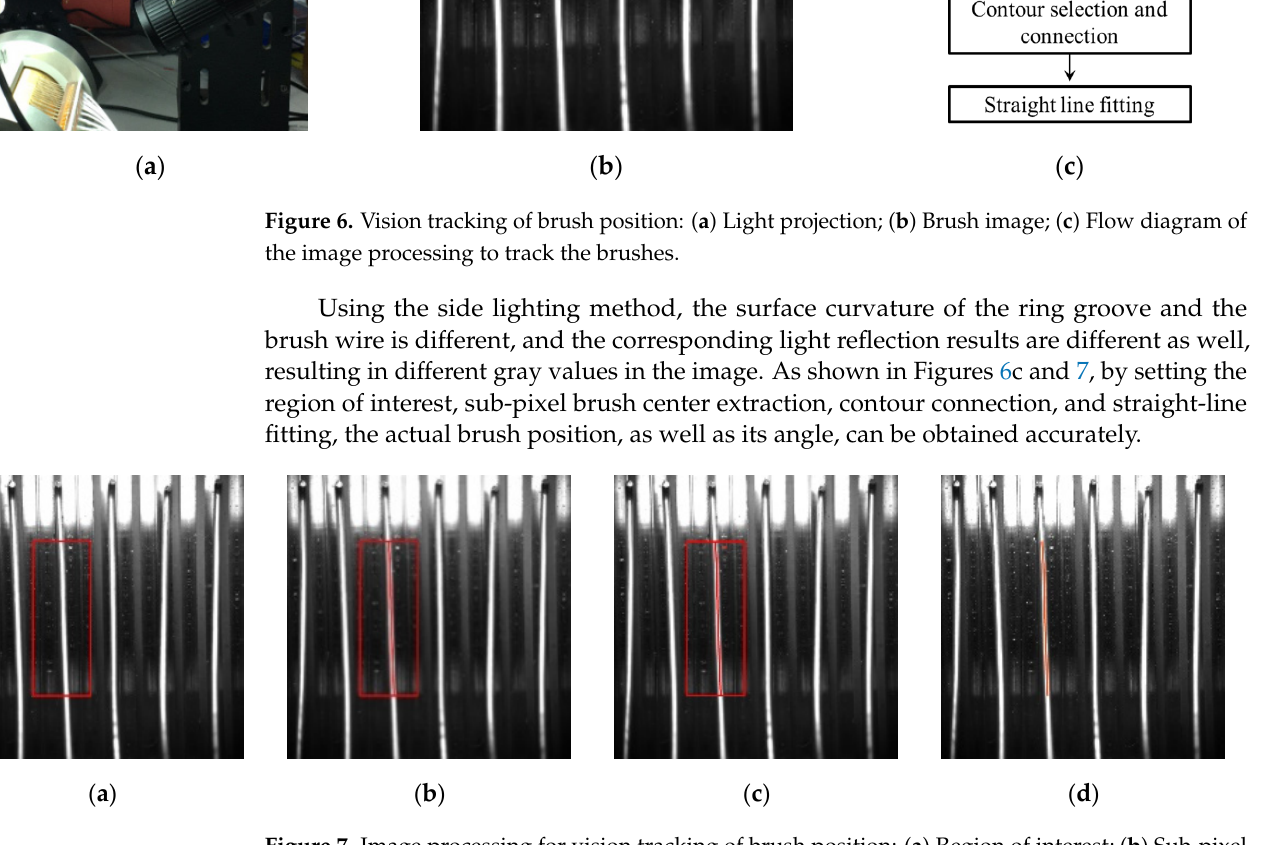
Figure 7. Image processing for vision tracking of brush position: ( a ) Region of interest; ( b ) Sub-pixel stripe center extraction; ( c ) Contour selection and connection; ( d ) Straight line fitting.